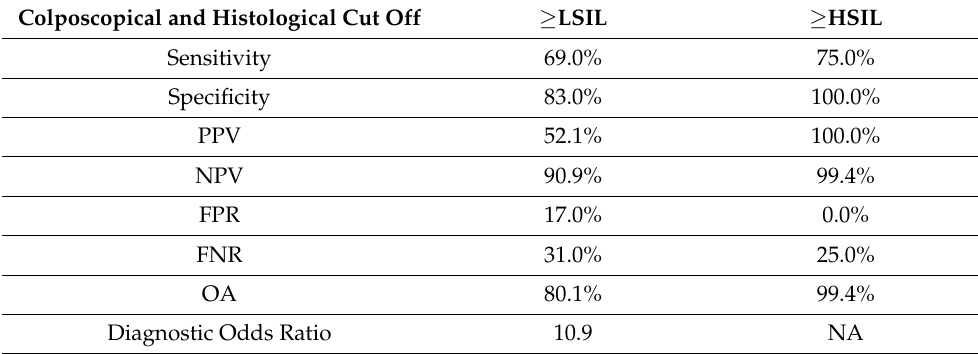
Table 4. Performance indicators of colposcopy using as gold standard the histological